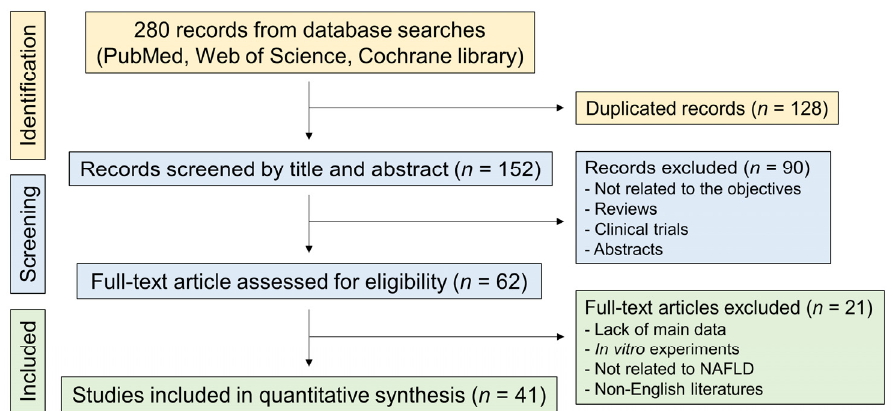
Figure 1. Flow diagram of the systematic literature search. NAFLD, nonalcoholic fatty liver disease.